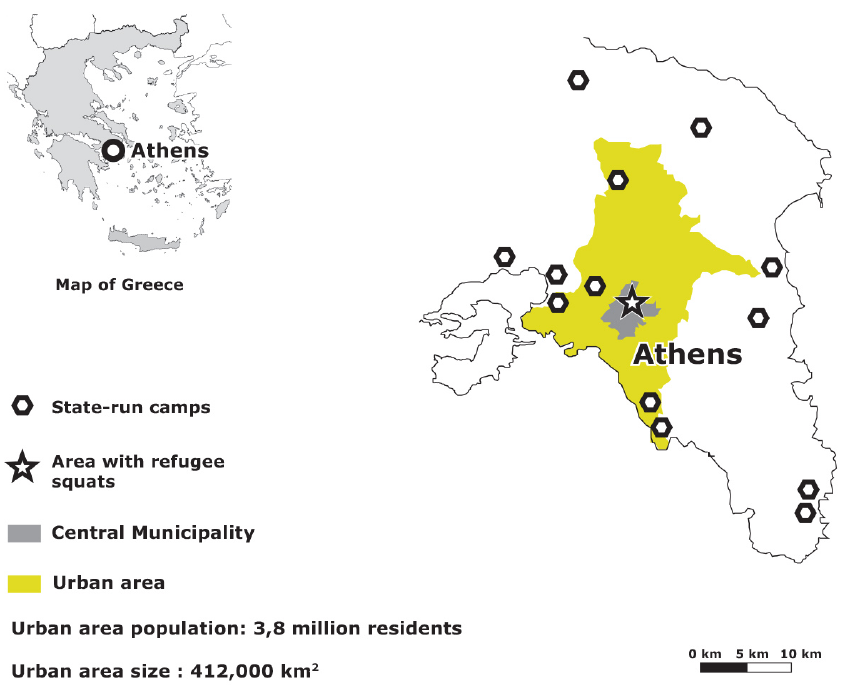
Figure 1. Locations of state-run refugee camps and refugee squats in Athens. Source: Authors, based on the land use map of Regulatory Urban Plan of Athens and Thessaloniki Metropolitan Areas (2014).